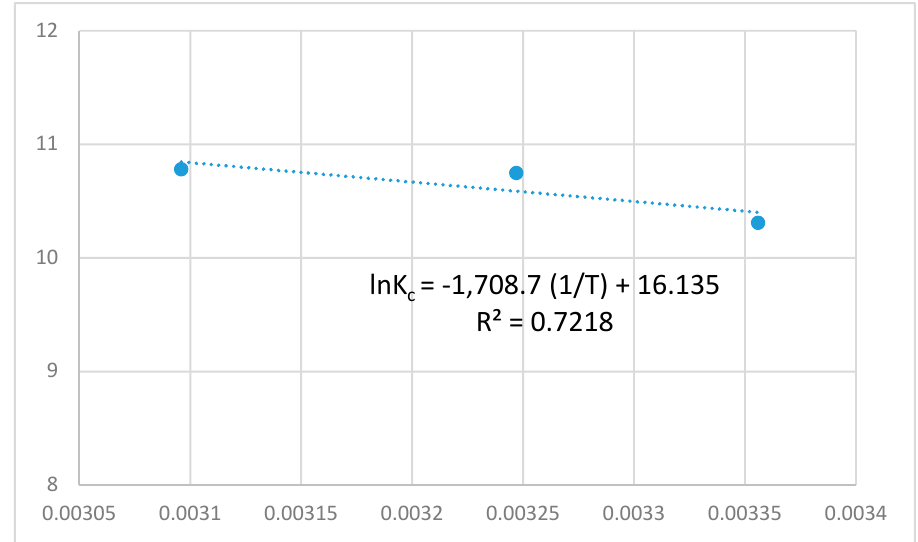
Figure 5. lnK c as a function of reciprocal of adsorption temperature.